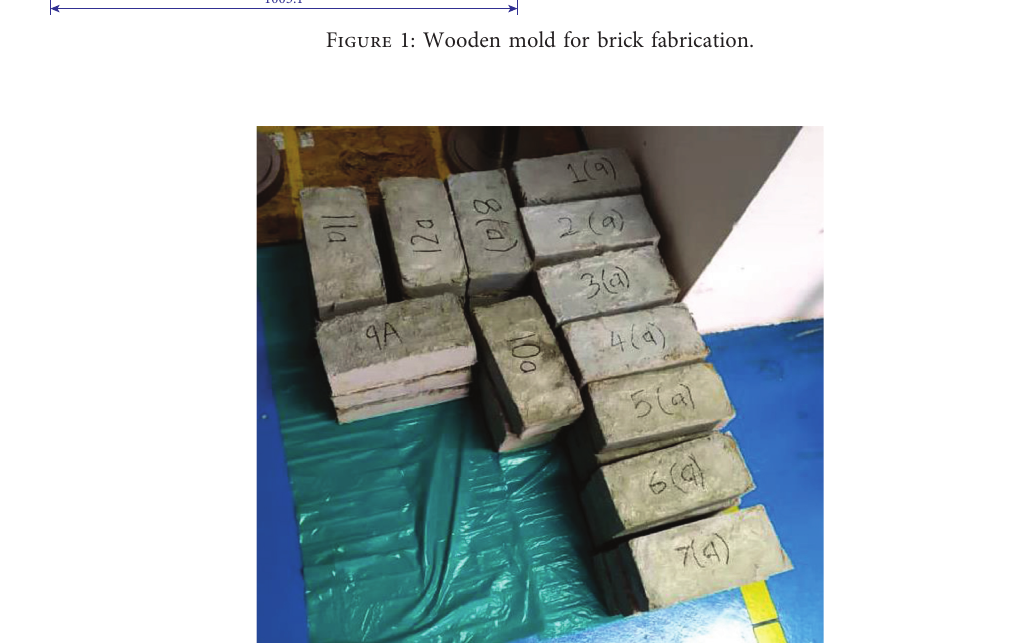
Figure 1: Wooden mold for brick fabrication.